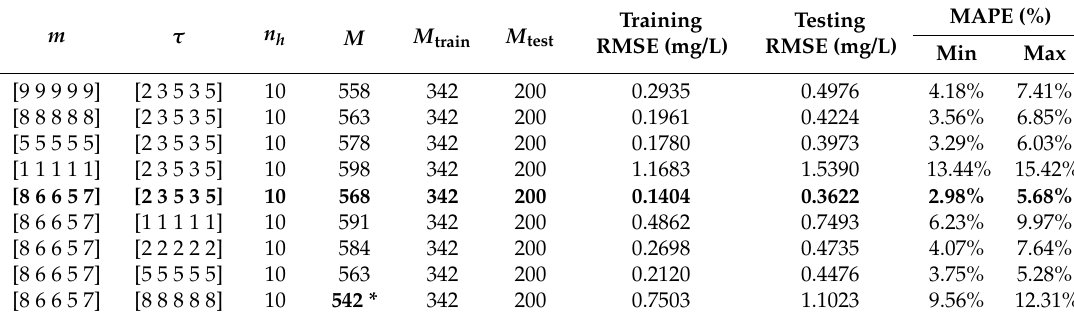
Table 6. The performance comparison with different τ and m for C-FNN